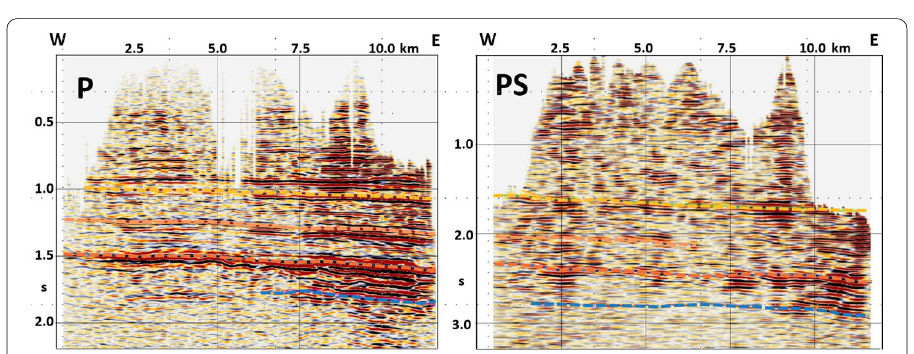
Fig. 7 Seismic profiles through the 3D3C a P-wave volume and b PS-wave volume. The position of the section is shown in Fig. 3c. Note the different scales of the sections. Light orange: Top Chattian, orange: Top Rupelian, dark orange: Top Priabonian, blue: base reservoir (Base Tithonian). The stronger noise on the PS-wave volume is due to the lower reflection coefficients of the